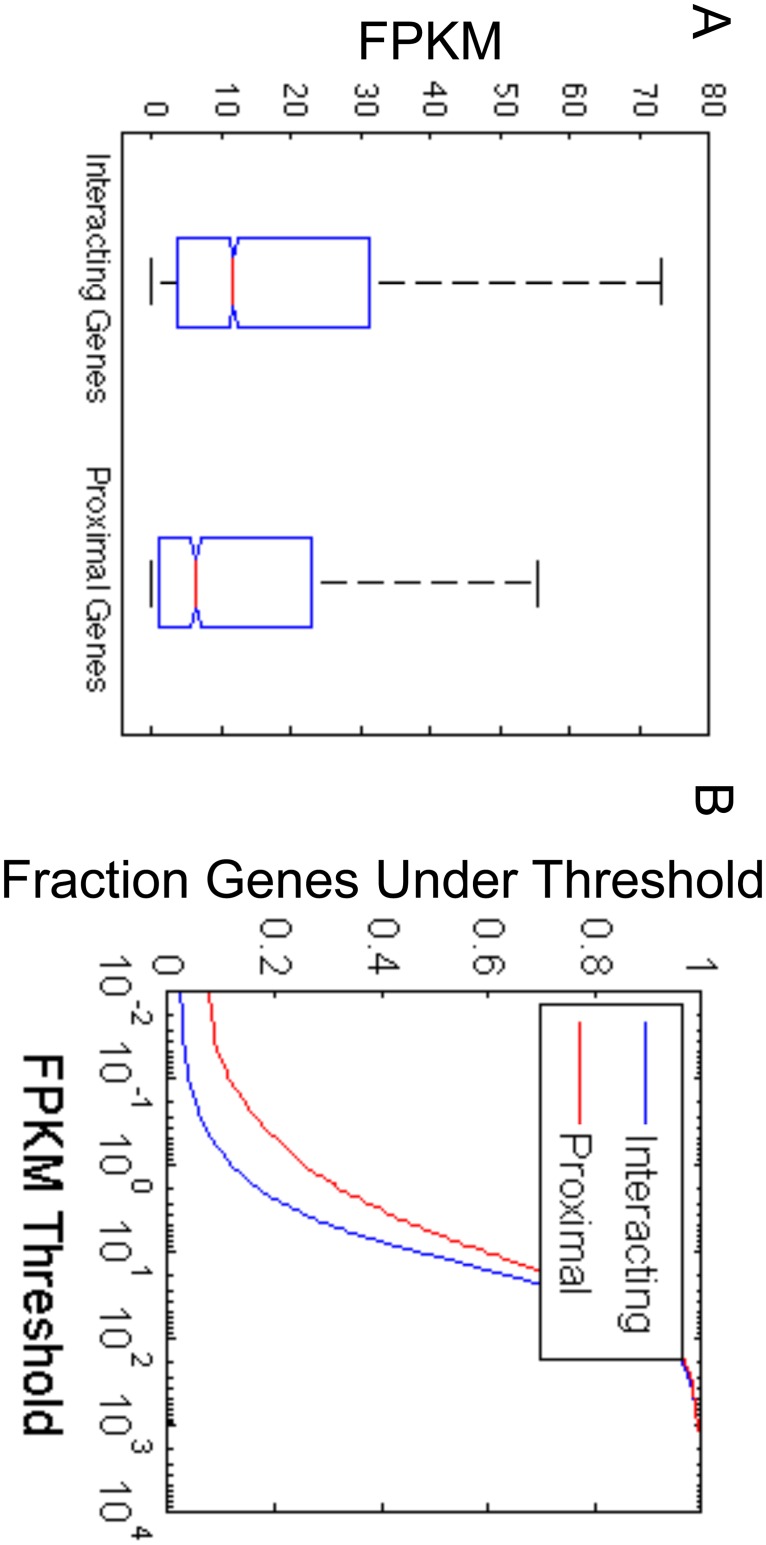
Considering interactions allows more highly transcribed genes to be identified than the set of genes that are closest to the locations that are detected to interact with TSSs.(A) The set of Interacting Genes is the set of genes for which their TSS is identified by Germ as interacting with at least one nonTSS location. The set of Proximal Genes is the set of genes for which their TSS is the closest TSS to the set of nonTSS locations that are identified by Germ as interacting with at least one TSS. The boxplots reflect the distribution of FPKM values computed for the genes in each group from the ESC RNA-Seq data. (B) The cumulative distributions of the transcription levels of the two sets of genes in ESCs demonstrate that a greater fraction of the genes proximal to the Germ identified nonTSS locations have transcription levels less than any FPKM threshold than the set of genes that interact with the nonTSS locations.